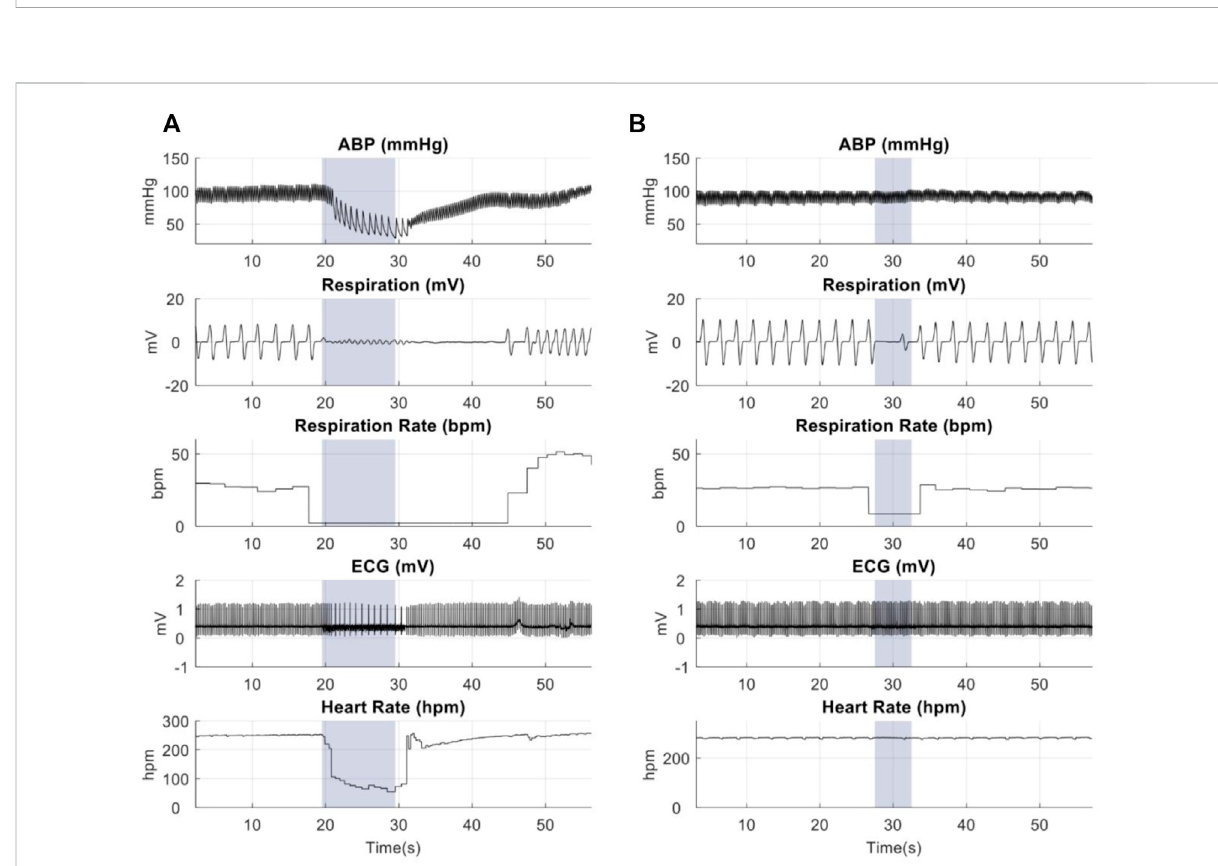
FIGURE 8 Representativephysiologicalrecordingsinanimalsreceiving (A) eVNS(0.5 mA,0.5 ms,20 Hz),and (B) µM-VNS(Vp-p=29.2±3.1V,20 Hz).The blue box shows the stimulation